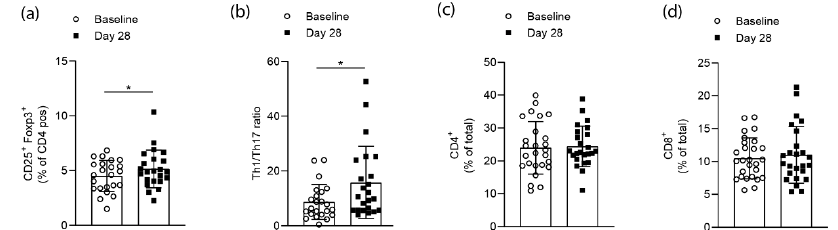
Figure 2. Short-term high-fiber supplementation e ff ects on T-cell populations of RA patients. ( a ) Flow cytometry analysis of CD4 + CD25 + FoxP3 + cells from whole blood samples of RA patients before and after high-fiber supplementation ( p = 0.0138); ( b ) Th1 / Th17 ratios for each participating RA patient calculated based on flow cytometry analysis for CD4 + T-bet + (Th1) and CD4 + ROR γ t + (Th17) cells ( p = 0.0135); ( c ) CD4 + and ( d ) CD8 + T cells from whole blood samples in RA patients. Data is expressed as mean ± SD. Statistical di ff erence was determined by Wilcoxon matched-pairs signed-rank